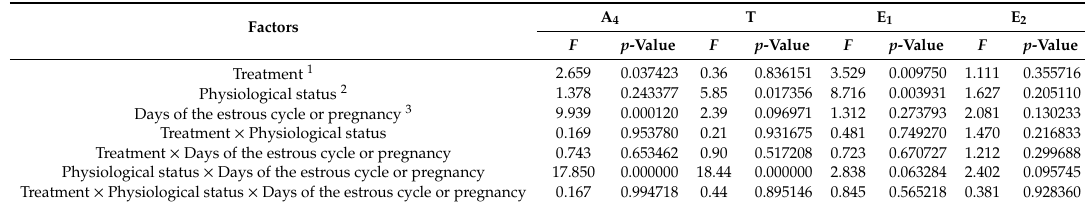
Table 3. Myometrial A 4 , T, E 1 and E 2 release—the main e ff ects and the interactions observed among factors (multiway ANOVA).